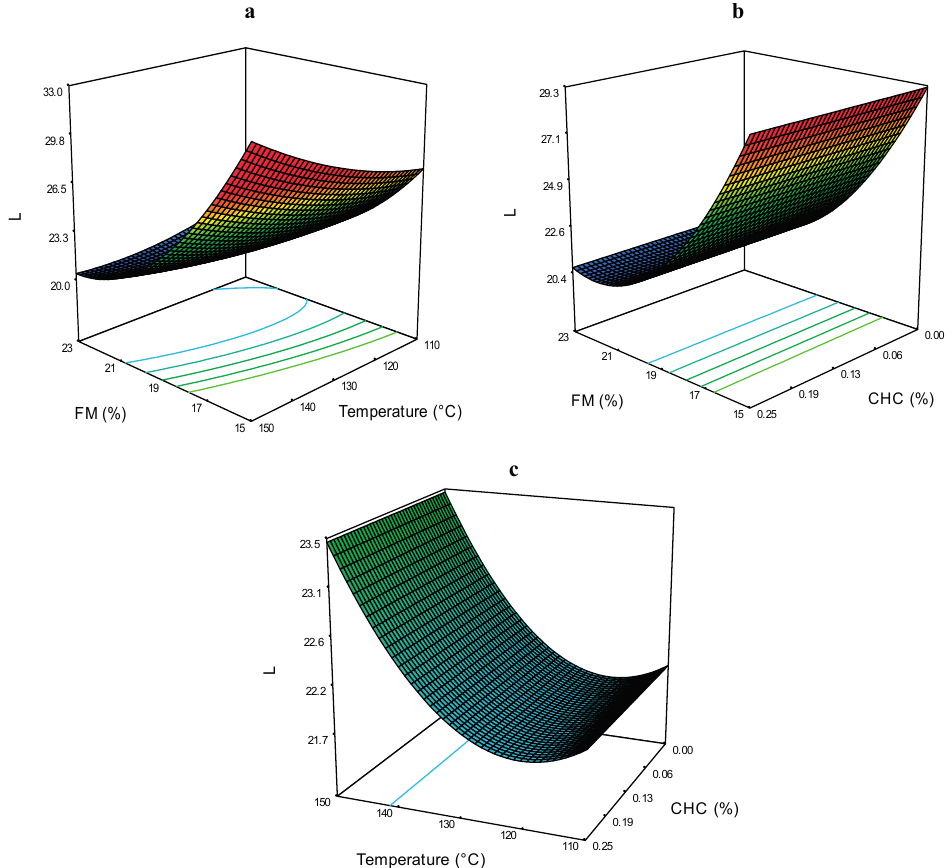
Figure 3. Color parameter L of expanded nixtamalized blue corn extrudates, as a function of: ( a ) feed moisture (FM) and temperature (T); ( b ) feed moisture (FM) and calcium hydroxide concentration (CHC); and ( c ) temperature (T) and calcium hydroxide concentration